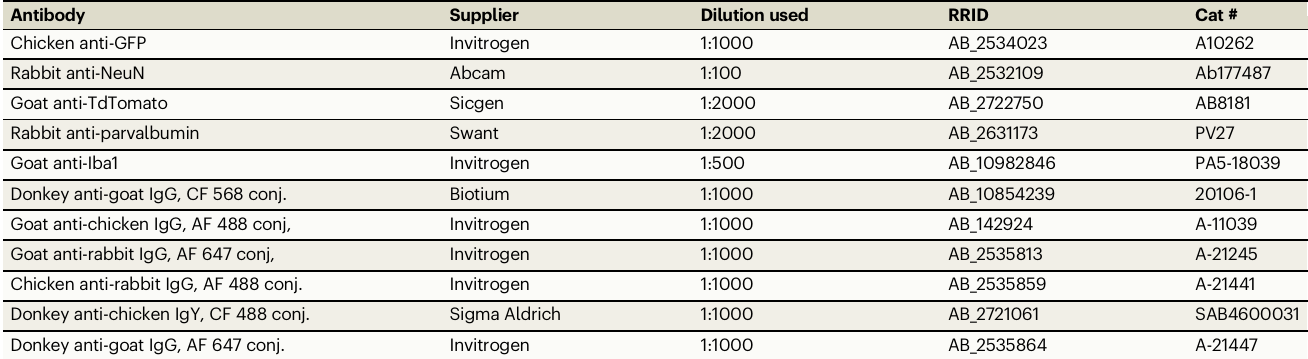
Table 3 | List of antibodies used for post-mortem histology